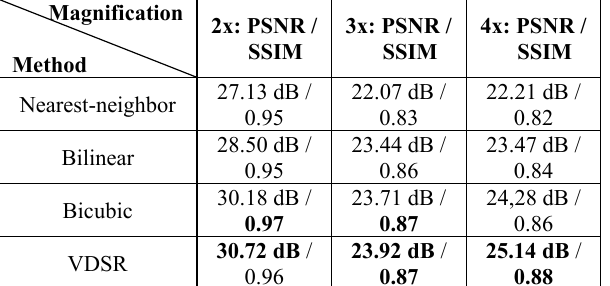
Table 1. Testing results for different methods and scale factors.